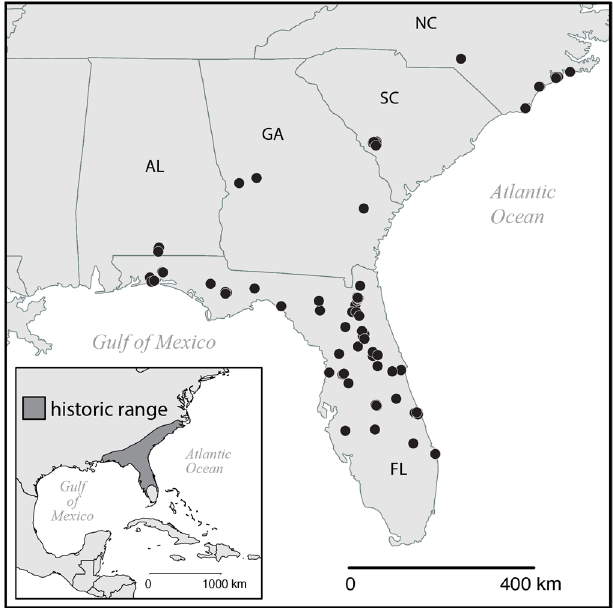
Figure 1. Sampled subpopulations of gopher frogs ( Rana capito ) in Alabama (AL), Florida (FL), Georgia (GA), North Carolina (NC) and South Carolina (SC). See Table S1 for further detail on sampling sites.